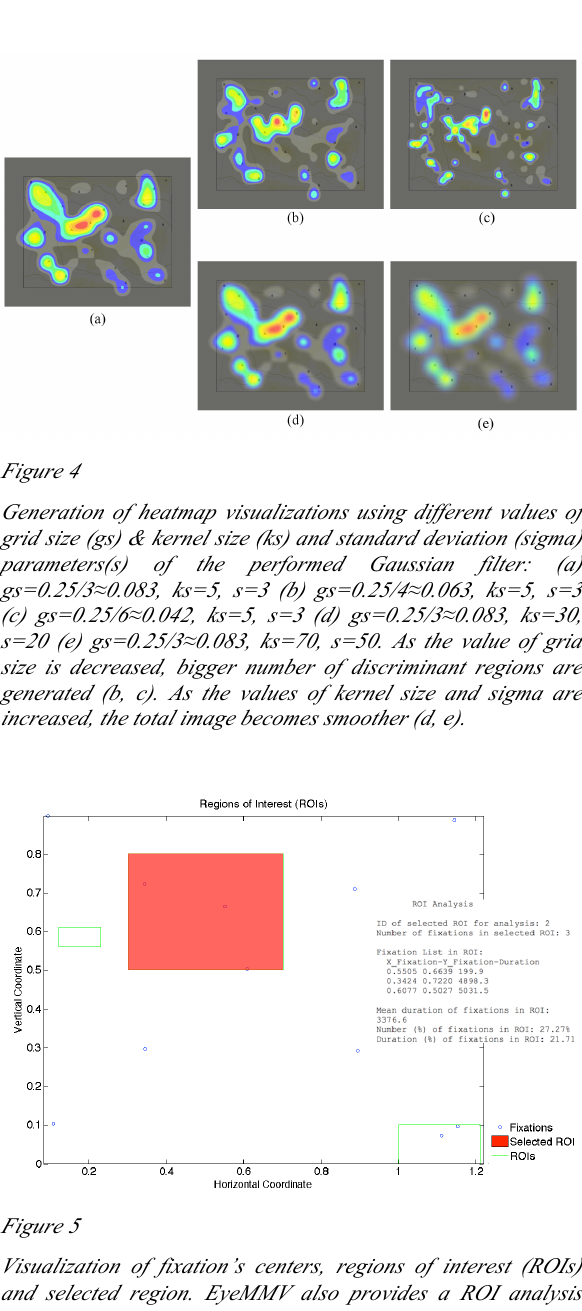
Visualization of fixation’s centers, regions of interest (ROIs) and selected region. EyeMMV also provides a ROI analysis